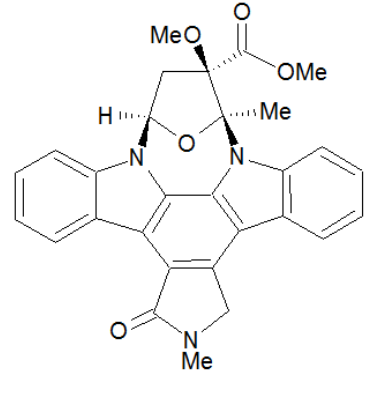
Figure 2. Chemical structure and name of K-Series inhibitor KT5823: (9 S ,10 R ,12 R )-2, 3,9,10,11,12-hexahydro-10-methoxy-2,9-dimethyl-1-oxo-9,12-epoxy-1 H -diindolo[1,2,3- fg : 3',2',1'- kl ]pyrrolo[3,4- i ][1,6]benzodiazocine-10-carboxylic acid, methyl ester.